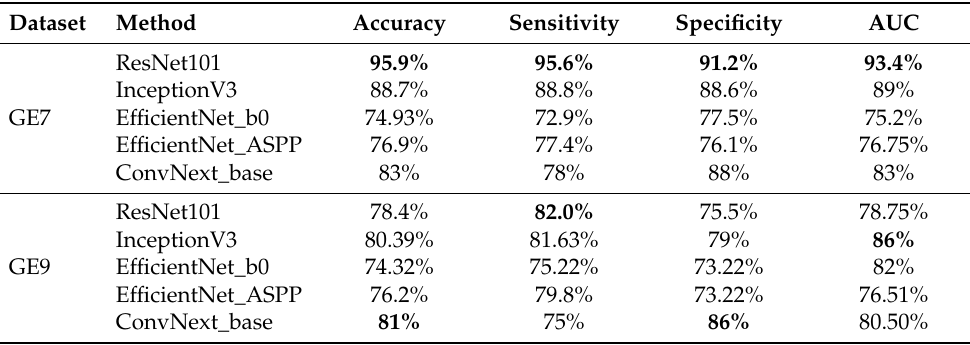
Table 4. Results obtained using transfer